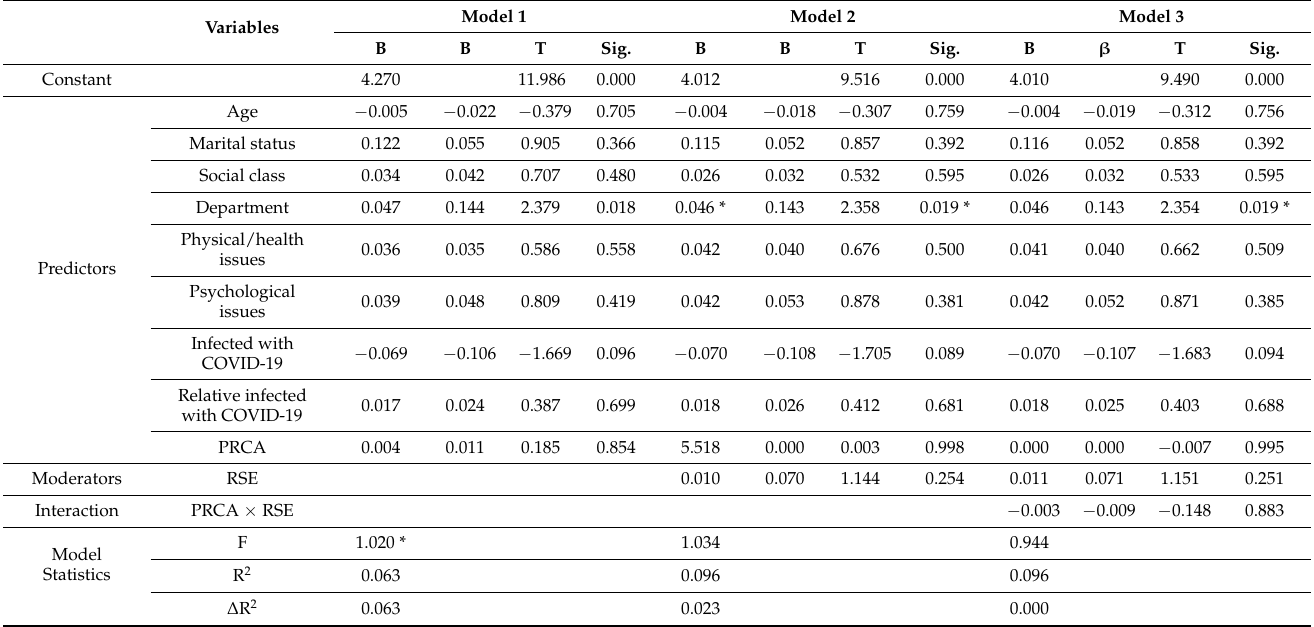
Table 7. Hierarchical moderating regression analysis for the predictors of GPA among study respondents.